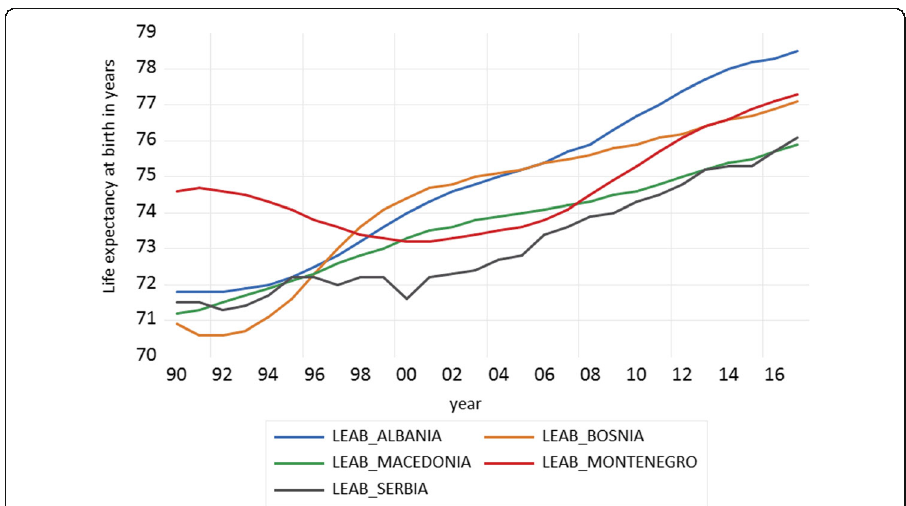
Fig. 3 Life expectancy at birth in EU accession candidate countries: 1990 – 2017: Life expectancy at birth in the EU accession candidate countries 1990 – 2017. Source: World Bank Group data. Author ’ s design based on EViews 11 software using annual time series data from Albania, Macedonia, Serbia, Bosnia and Herzegovina, and